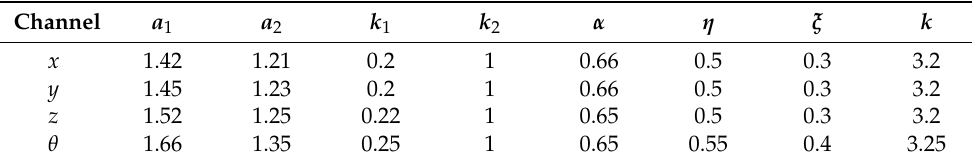
Table 2. Main parameters of the